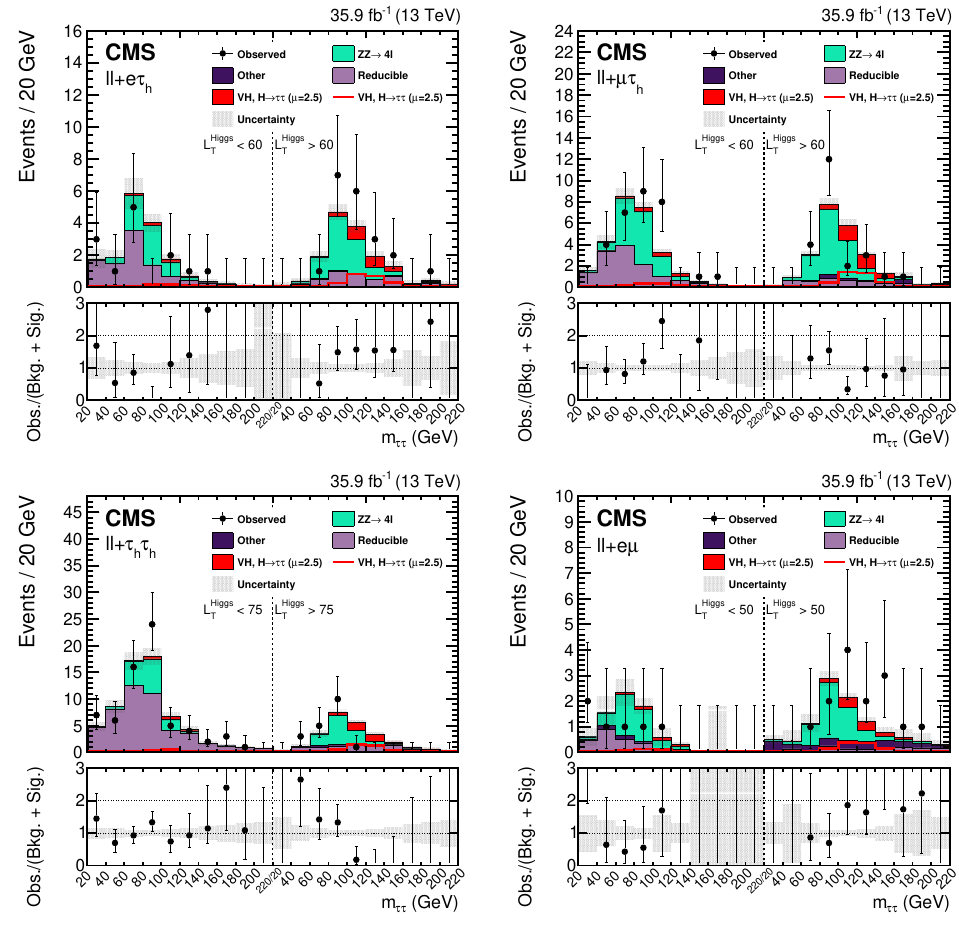
Figure 1 . The post-(cid:12)t m (cid:28)(cid:28) distributions used to extract the signal shown for (upper left) ‘‘ + e (cid:28) h , (upper right) ‘‘ + (cid:22)(cid:28) h , (lower left) ‘‘ + (cid:28) h (cid:28) h , and (lower right) ‘‘ +e (cid:22) . The uncertainties include both statistical and systematic components. The left half of each distribution is the low L Higgs region, T while the right half of each distribution is the high L Higgs region. The WH and ZH, H ! (cid:28)(cid:28) signal T processes are summed together and shown as VH, H ! (cid:28)(cid:28) with a best (cid:12)t (cid:22) = 2 : 5. VH, H ! (cid:28)(cid:28) is shown both as a stacked (cid:12)lled histogram and an open overlaid histogram. The contribution from \Other" includes events from triboson, tt+W/Z, ttH production, and all production modes leading to H ! WW and H ! ZZ decays. In these distributions the ZH, H ! (cid:28)(cid:28) process contributes more than 99% of the total of VH, H ! (cid:28)(cid:28)